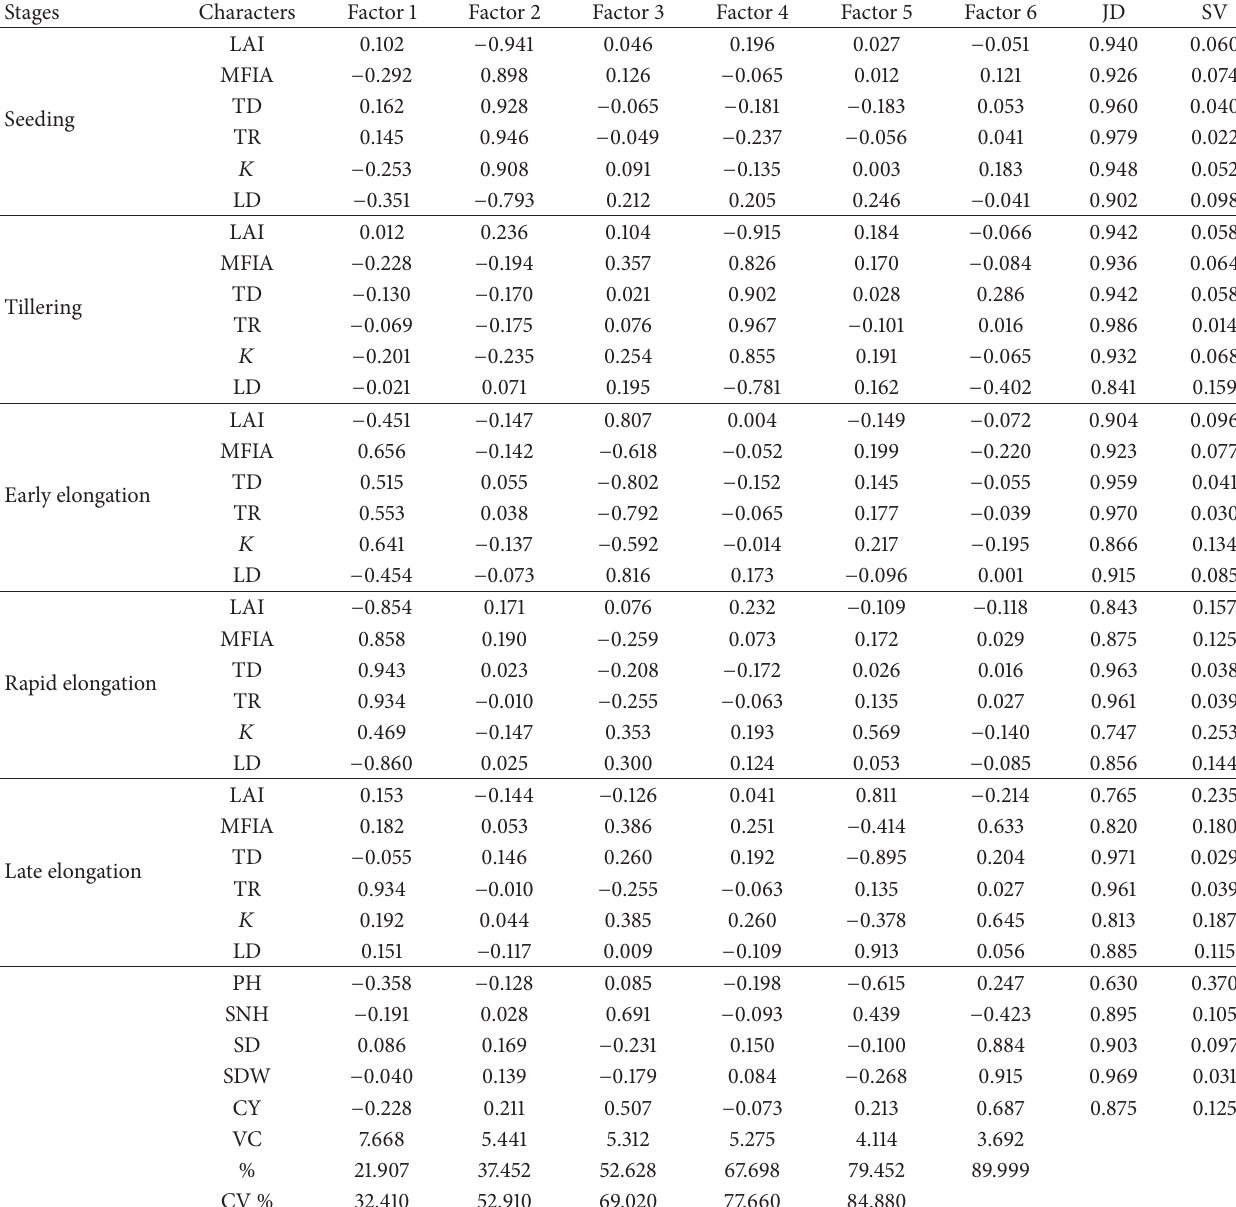
Table 9: Loading matrix of varimax orthogonal rotation